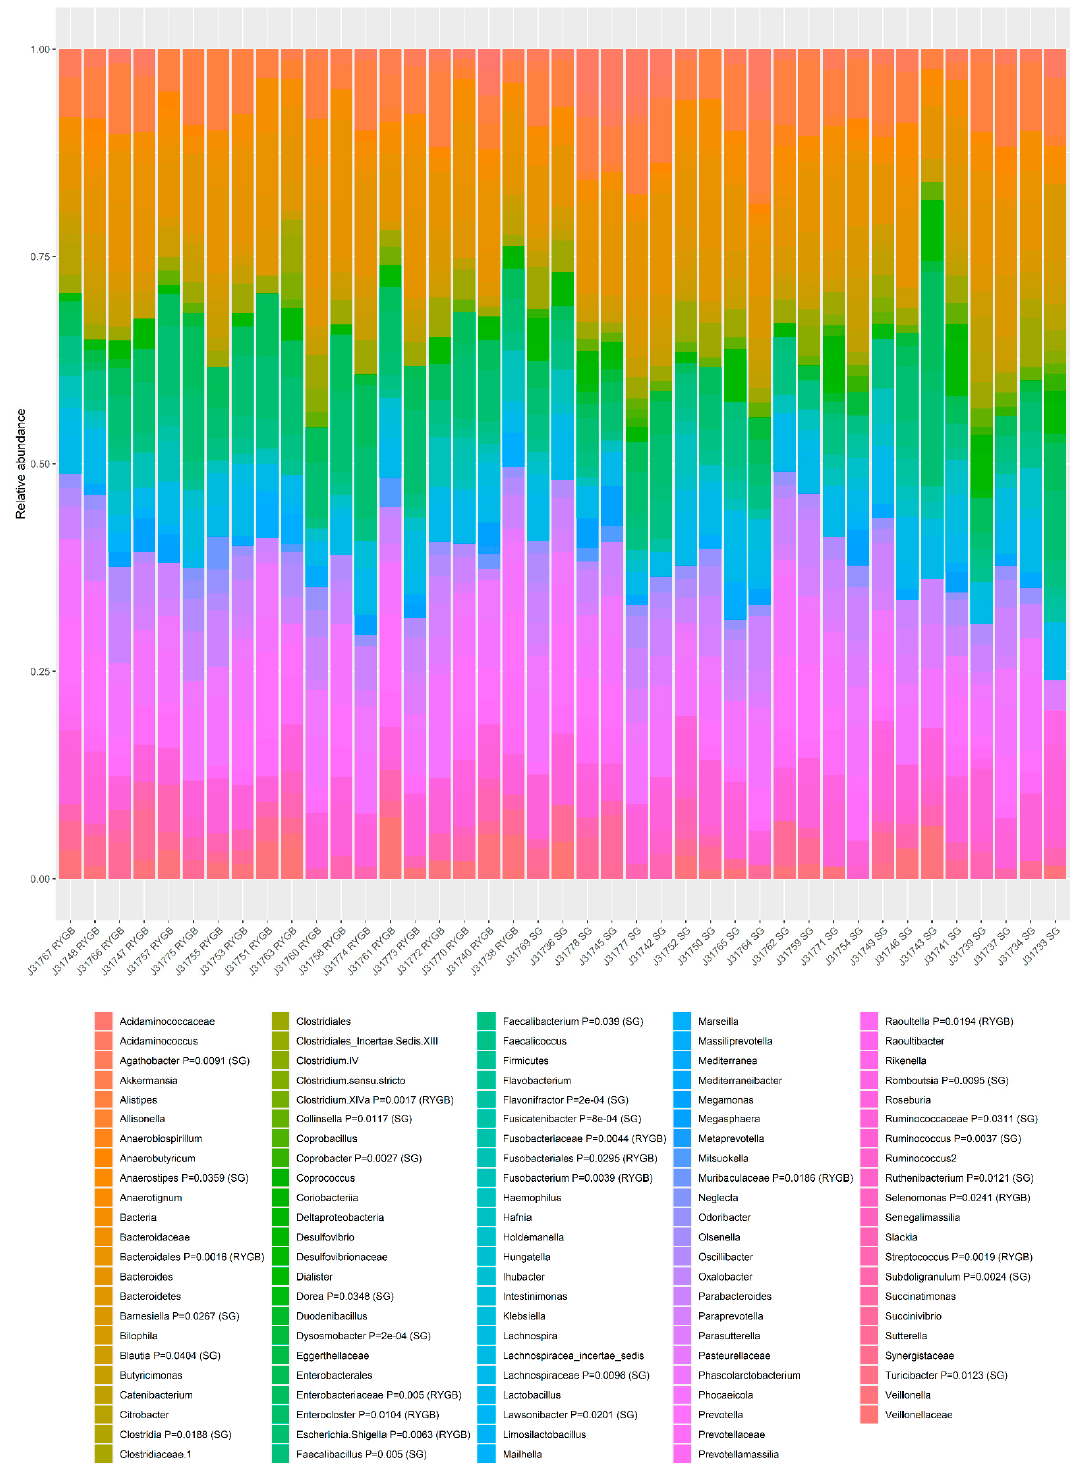
Figure 3. The composition of gut microbiota (relative abundance of OUT) based on the 16S rRNA gene sequencing by sample and type of surgery. Relative abundance of OTUs is shown for each patient. Patients are arranged by type of surgery. In the legend, the p value and group (RYGB or SG) for which the highest association was found for a given taxon are shown. The association between taxa patterns and groups was performed by multilevel pattern analysis.